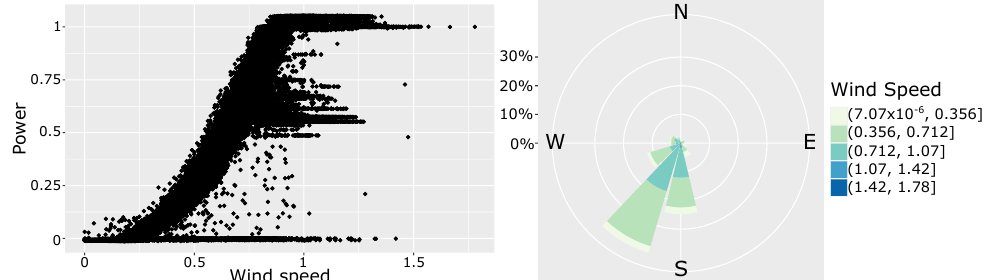
Figure 2. Power Curve and wind rose for the